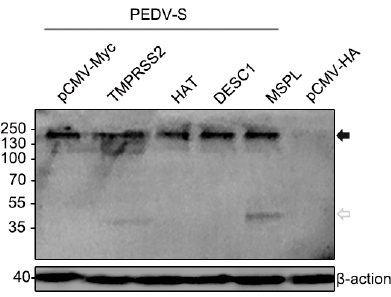
Figure 5. TMPRSS2 and MSPL cleave the PEDV S protein. Black-filled arrowheads, uncleaved S protein; white-filled arrowheads, N-terminal cleavage fragments.